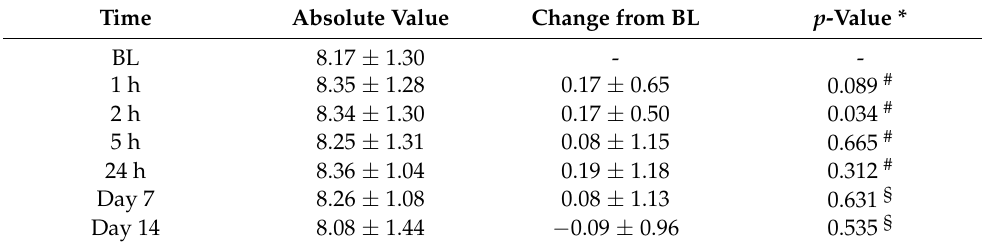
Table 6. Absolute transepidermal water loss (TEWL) measurement values (forearm, area A1) and changes from the baseline after a single application of the body wash gel (first 24 h) followed by once-daily applications for 13